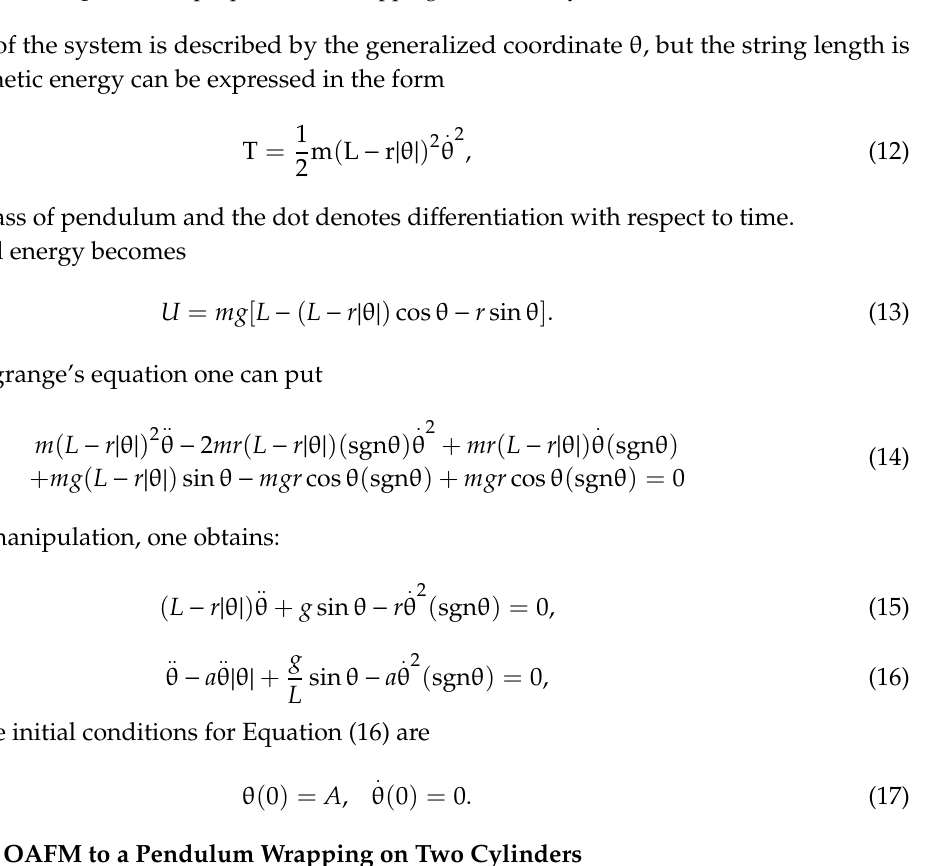
Figure 1. Simple pendulum wrapping around the cylinders.